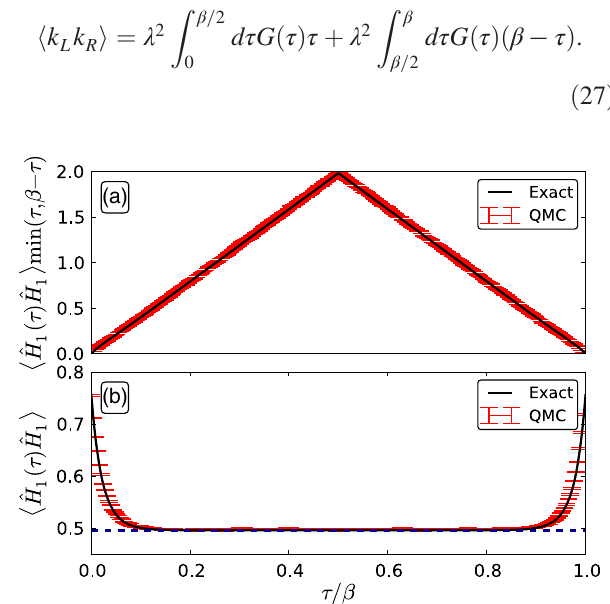
FIG. 7. (a) Histogram obtained by counting separable vertex pairs with distance τ compared with the exact result of ˆ H τ Þ ˆ H τ ; β − τ g . (b) Histogram obtained by counting h 1 ð 1 i max f vertices with distance τ compared with the exact results of ˆ H τ Þ ˆ H τ close to β = 2 , the correlator approaches h ˆ H h 1 ð 1 i . For indicated by the dashed blue line. These simulations are per- formed for the Hubbard model Eq. (26) on a four-site open chain with λ =t ¼ − 2 and β t ¼ 8